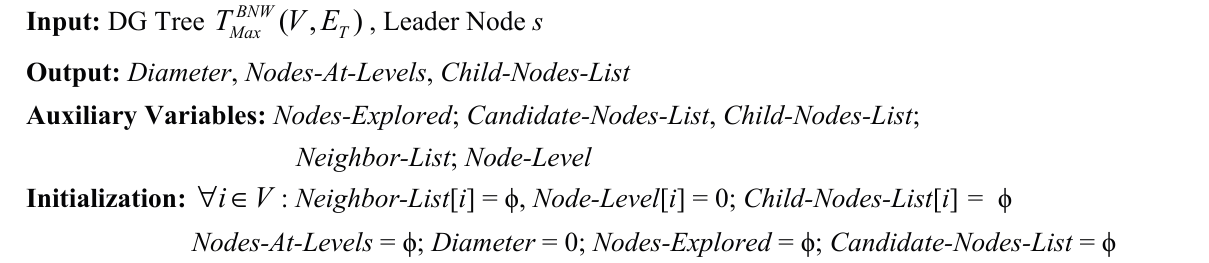
Algorithm 5. Pseudo Code for an Algorithm to Determine the Diameter of a Data Gathering